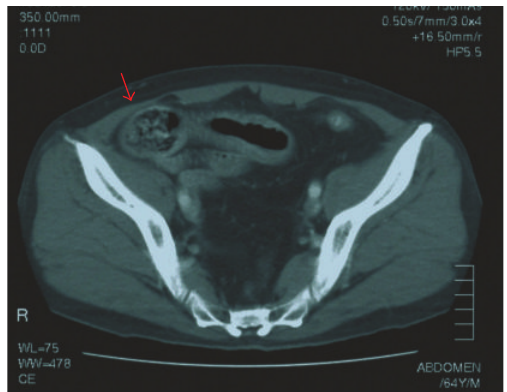
Figure 2: Pelvic CT shows a dilated small bowel loop and a mass measuring 4cm.